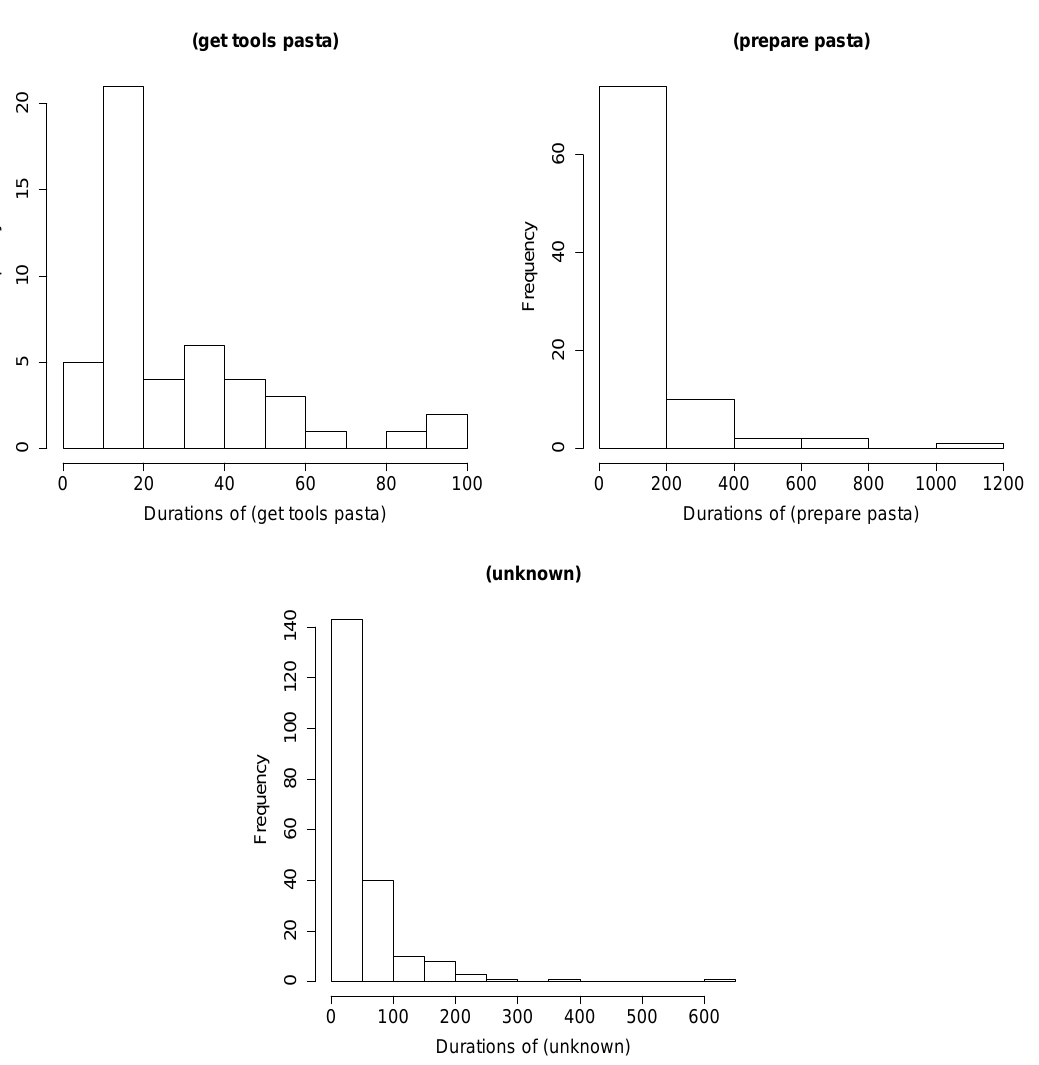
Figure 8. Frequency of the durations of some actions in the